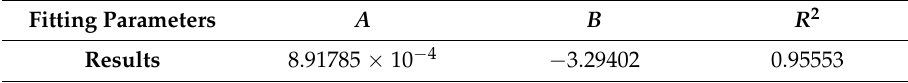
Table 6. Fitting Parameters of Fatigue